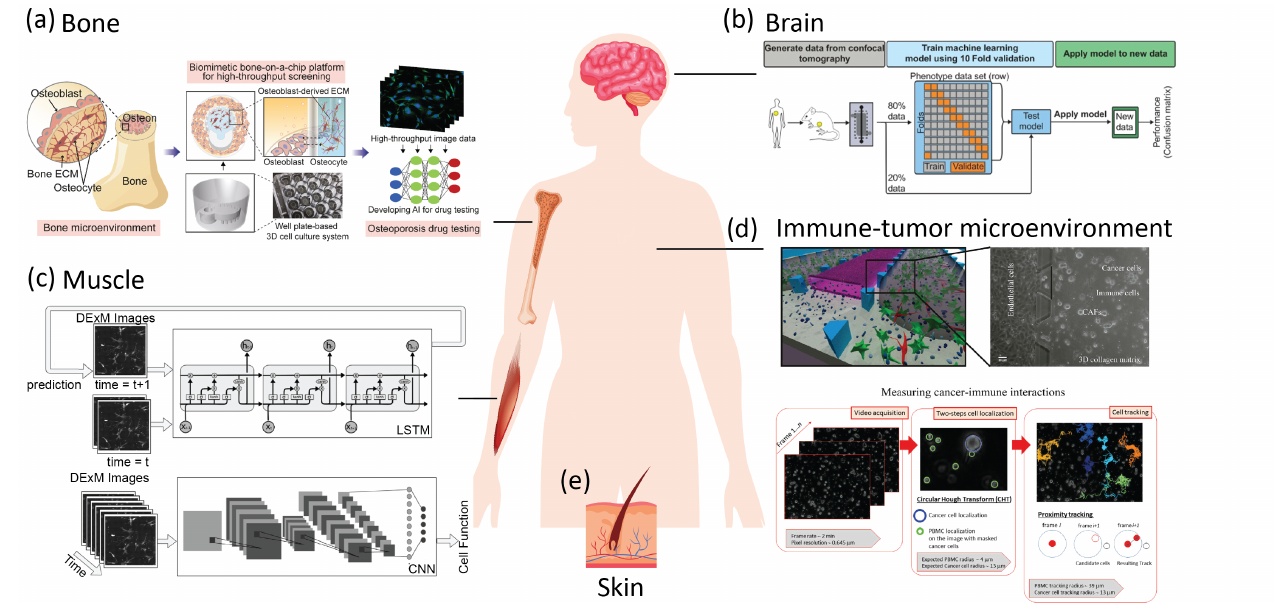
Figure 6. Organ-on-chip platforms integrated with AI analysis. ( a ) A bone-on-chip for osteoporosis drug testing and development [298]. Reproduced under CC–BY license. ( b ) A blood–brain niche OoC for predicting the metastatic probability of brain cancer [299,300]. Adapted with permission from [300]. ( c ) A muscle-on-chip with AI image analysis for quantitative understanding of muscular cell phenotypes. Reprinted with permission from [302]. ( d ) An OoC to reconstitute immunocompetent tumor microenvironment in breast cancer [305,306]. Reproduced under CC–BY license. ( e ) A skin-on- chip for predicting adverse cutaneous drug reactions [301]. Components in the figure were designed by macrovector;